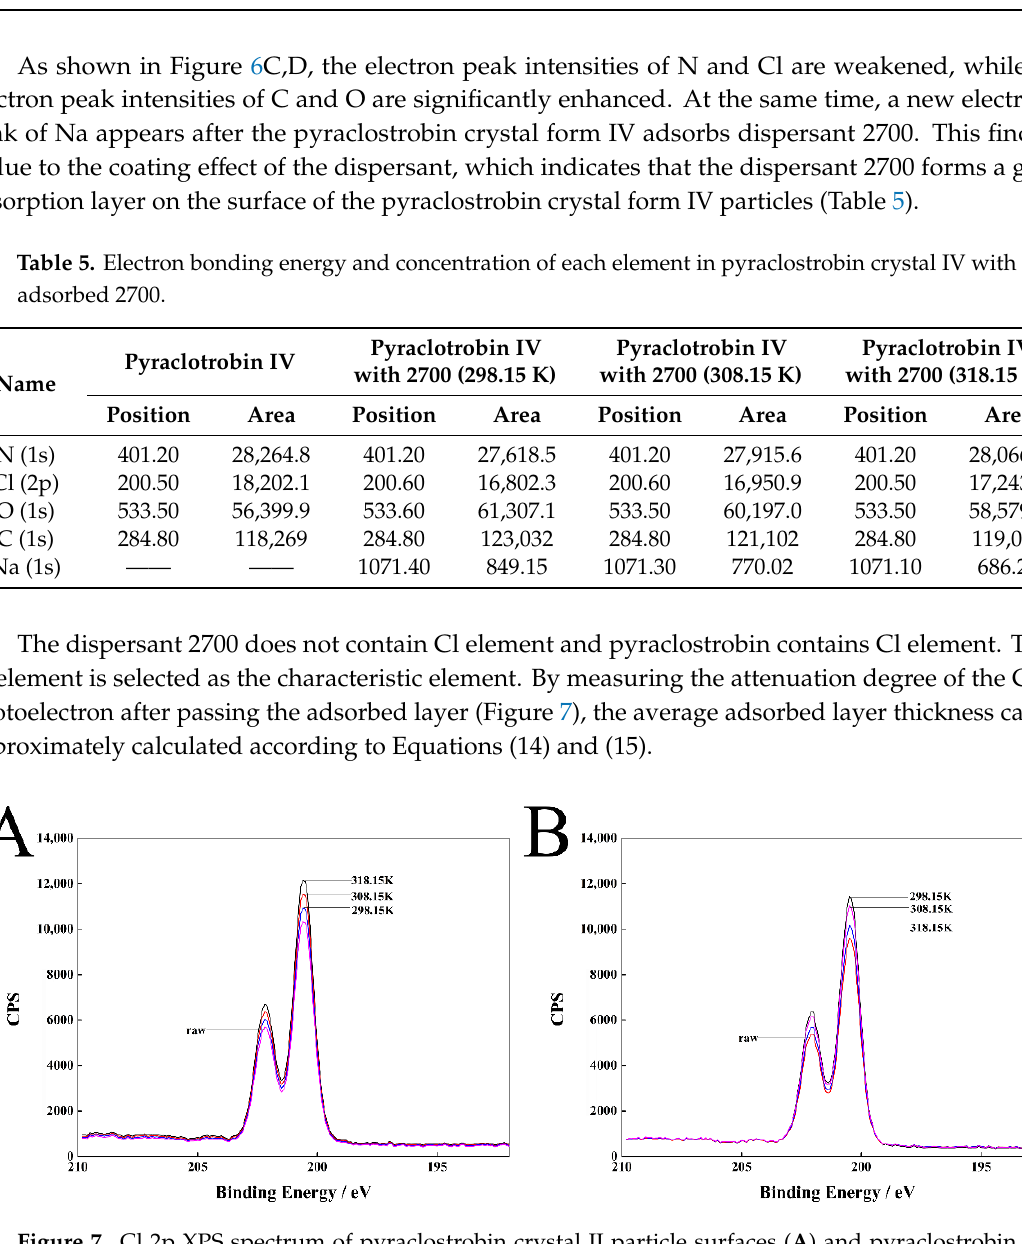
Table 6. Adsorption layer thickness of 2700 on two pyraclostrobin crystal particle surfaces at different temperatures. T/K